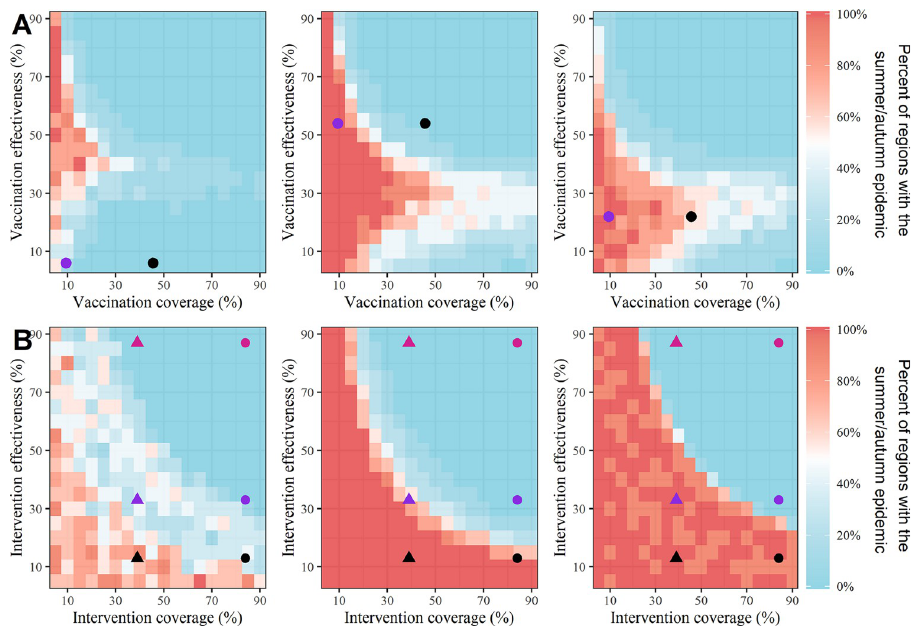
Fig 3. The effects of pharmaceutical intervention (vaccination program, A) and non-pharmaceutical intervention (using facemasks plus hand hygiene, B) on the summer epidemics of influenza A(H3N2) in 2013/2014 (Left), 2014/2015 (Middle) and 2016/2017 (Right) . The triangles and circles in the top panel represent the influenza coverage in China (9.4% [19]) and United States (43.8% [20]), respectively; while the color represents the average (black, 29%) and season-specified vaccine effectiveness (blue,0.09 for 2014/2015 [16], 0.54 for 2015/2016 [17] and 0.22 for 2017/2018 [18]). The triangles and circles in the bottom panel show the percentage of the population using facemasks plus hand hygiene in the non-pandemic period (39% [22]) and pandemic period (84% [23]), respectively. The color in the triangles or circles represents the low (13%, black), middle (23%, blue), and high (87.0%, red) effectiveness of using facemasks plus hand hygiene to prevent influenza A(H3N2) [21], respectively.